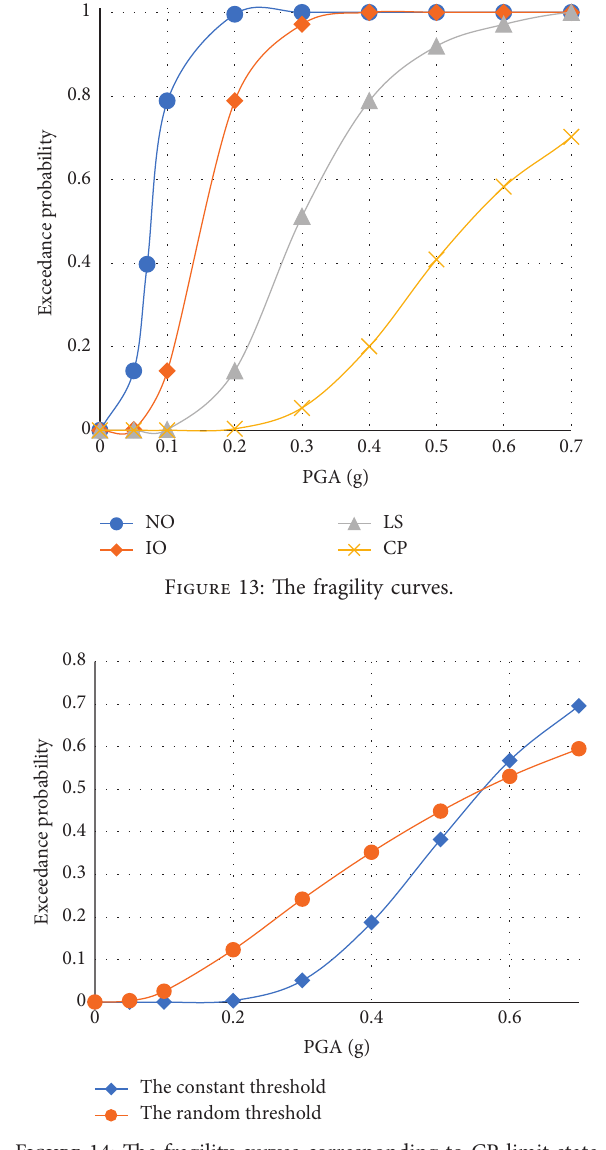
Figure 14: The fragility curves corresponding to CP limit